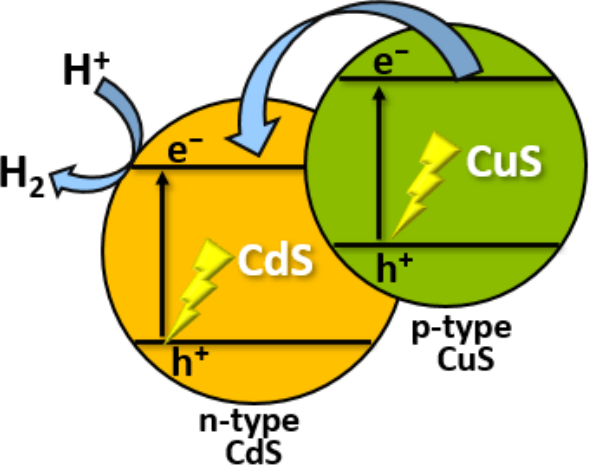
Figure 5. Mechanism of photocatalytic H 2 evolution using CdS/CuS nanocomposite .